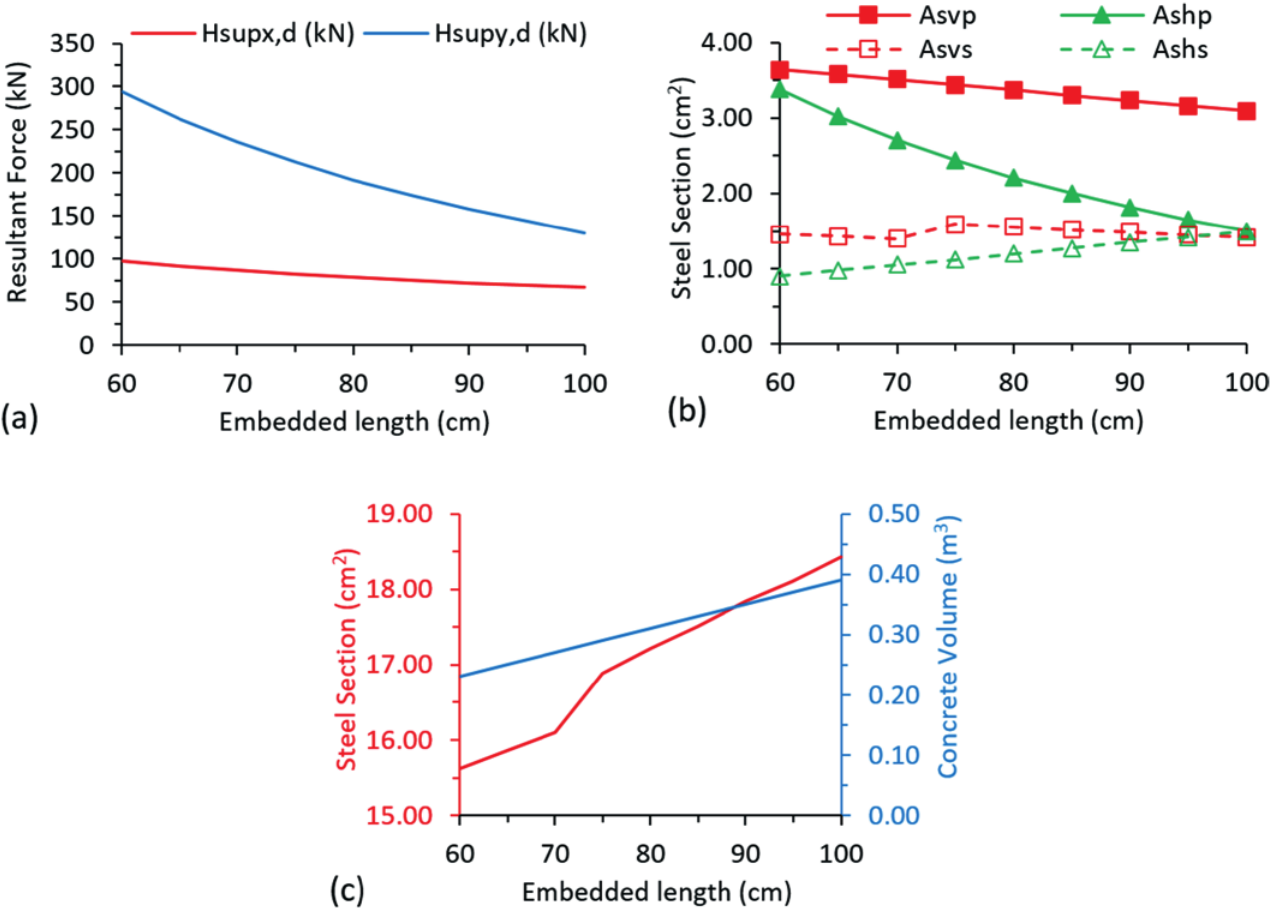
Influence of the variation of the embedded length on the upper resultant forces (a), on the calculated reinforcement section (b) and on the consumption of the materials